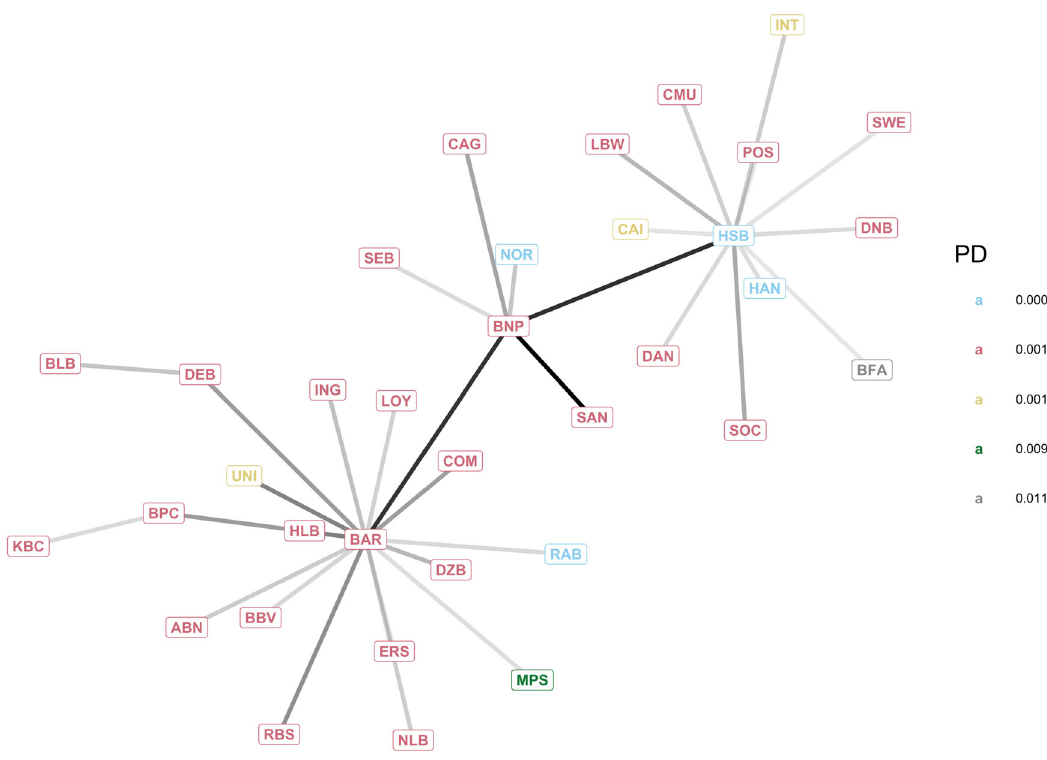
Fig. 4 | Maximum spanning tree of the European Banking Authority (EBA) network. The network of the European Union ’ s Global Systemically Important Institutions (GSII) has been reconstructed from aggregated data available at the